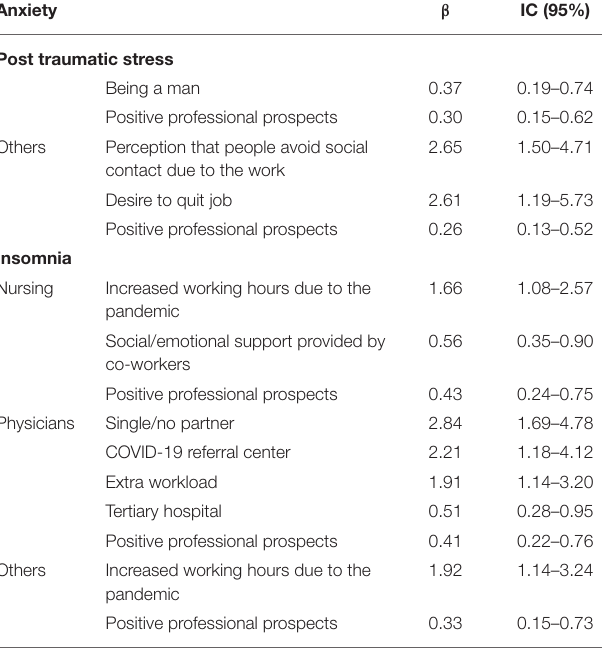
TABLE 3 | Predicting variables that compose the final regression model for anxiety, depression, posttraumatic stress, and insomnia according to